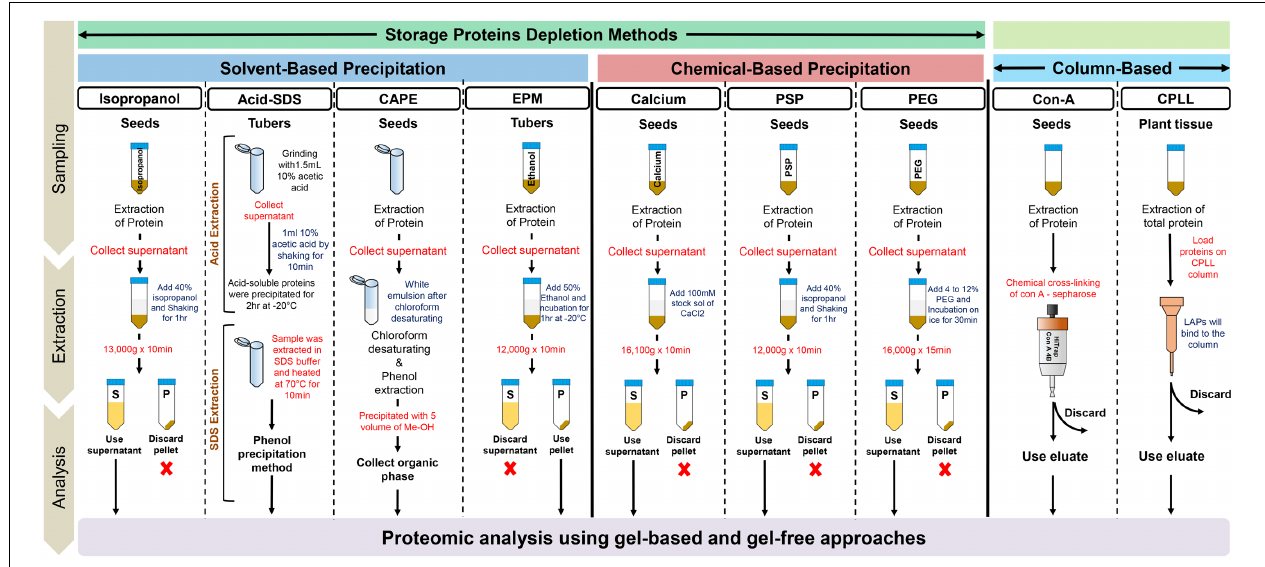
FIGURE 1 | A summary of the workflows developed for the enrichment of low-abundance proteins (LAPs) in seeds and tuber samples using HAPs depletion and CPLL methods. Details of these techniques are mentioned in the text and in the cited references.